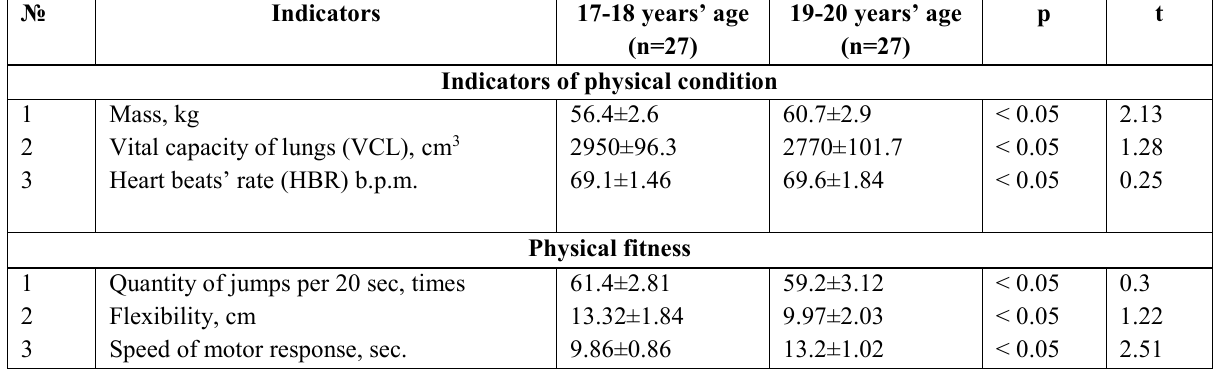
Confidence of indicators of first and second year girl students of experimental